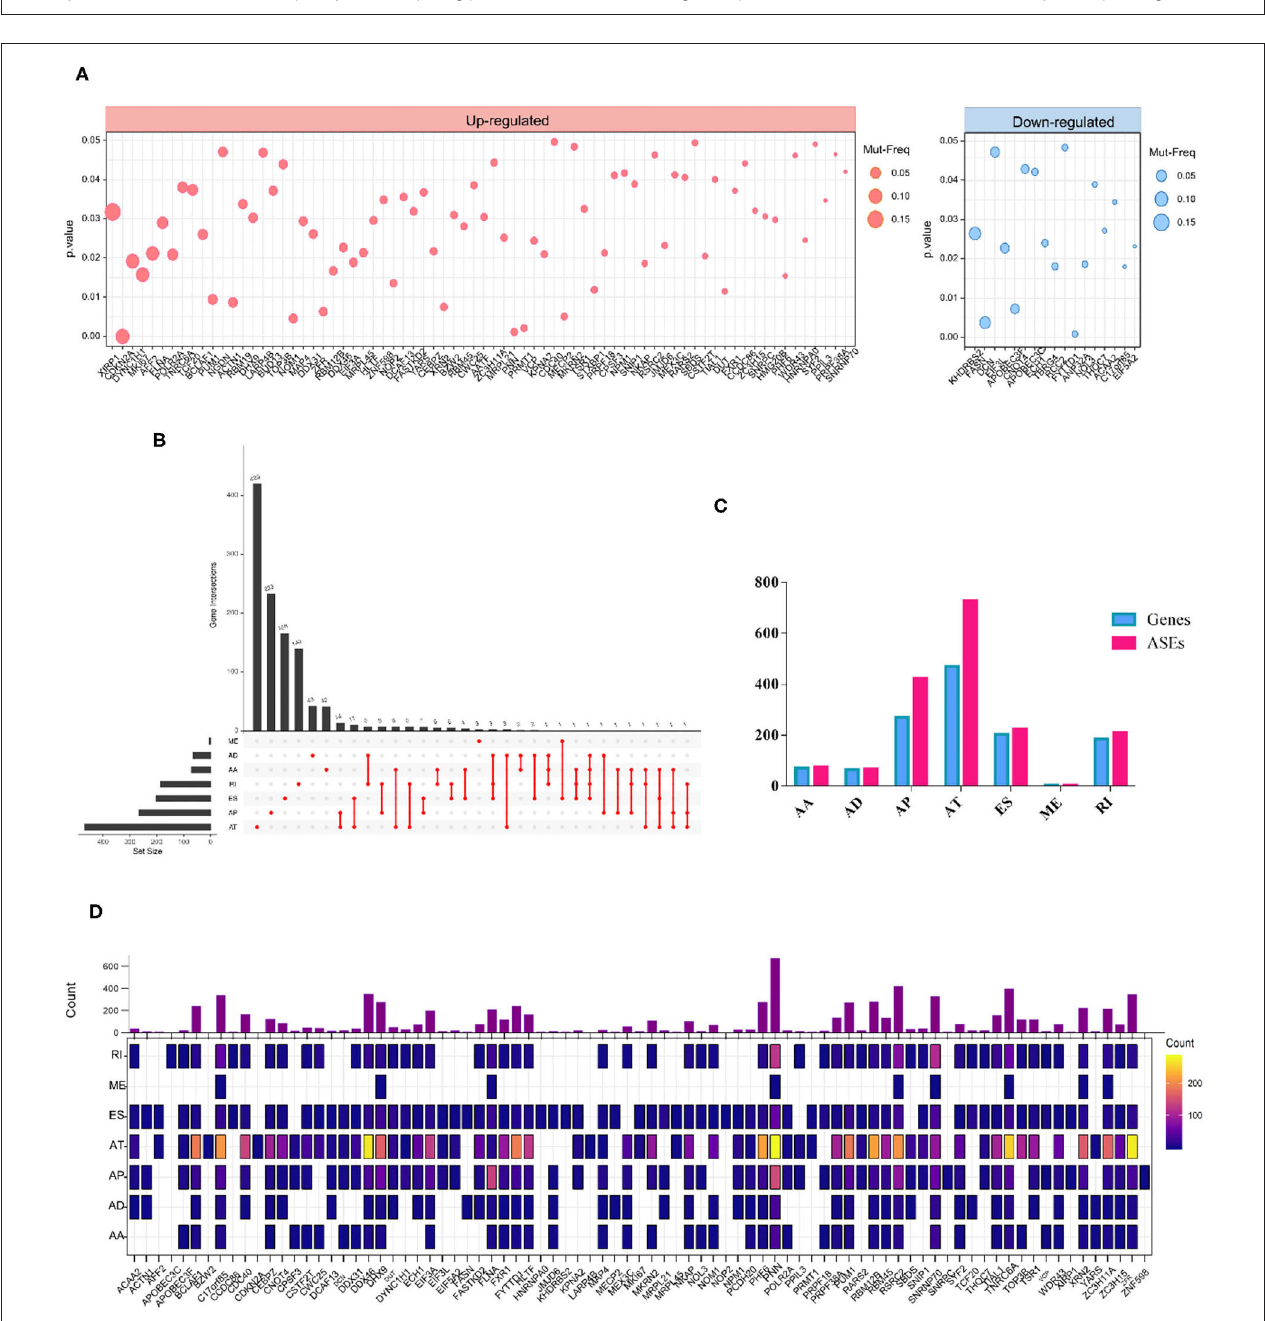
FIGURE 2 | mutations. The black bar on the left side indicates the event number of specific splicing type, and the red dots on the right side represent the intersections of ASEs. (C) Distribution of seven types of ASEs and their corresponding genes. The x-axis represents each kind of ASEs (AA, AD, AP, AT, ES, ME, RI), and the y-axis represents the number of ASEs (red) or the corresponding spliced genes (blue). (D) Overview of splicing events per RBP with the highest mutation frequency. The color intensity indicates the occurrence frequency of each splicing pattern, and the above histogram represented the counts of ASEs affected by corresponding RBPs.